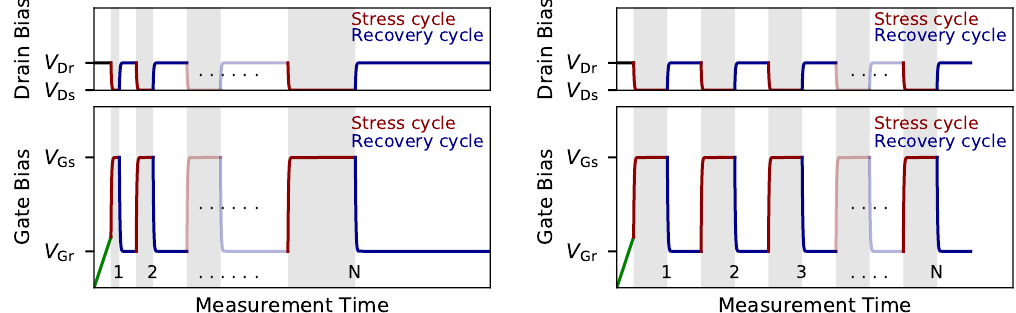
Figure 2. Schematic of the bias signals which are typically used for the measure-stress-measure (MSM) scheme which is applied for ( left ) the characterization of large-area devices, and ( right ) for defect-spectroscopy in nanoscale devices. An IDVG sweep is measured within a narrow gate bias range before the first stress cycle is applied. While the stress and recovery times are successively increased after each cycle for the characterization of large-area devices, N repetitions of the same sequence are performed when single-defects in nanoscale devices are